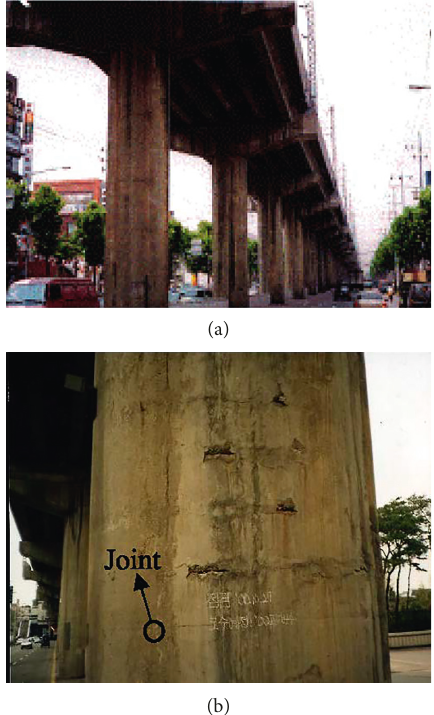
Figure 1: Examples of railway bridge RC columns monitored to assess carbonation effect. (a) Railway bridge. (b) Cracks and joint in the